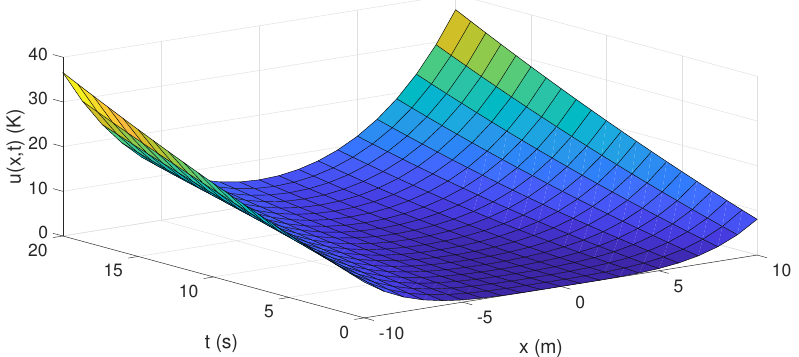
Figure 1. Scalar field resulting from Equation (11) with β 1 = 0.8 × 10 − 3 , β 2 = 0, β 3 = 0, and α =